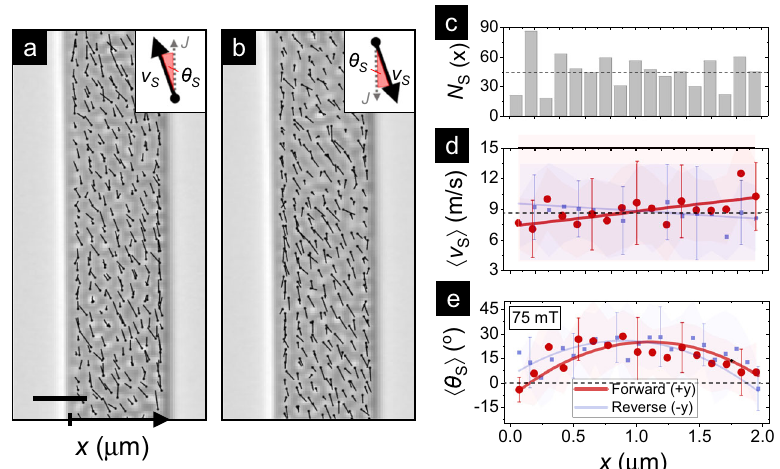
Fig. 3 Con fi nement effects on skyrmion fl ow dynamics. a , b Representative MFM images (scale bar: 1 μ m) at μ 0 H ≃ 75 mT showing the forward ( J k þ ^ y ) ( a ) and reverse ( J k (cid:4) ^ y ) ( b ) plastic fl ow of skyrmions with varying distance x from the left edge. Overlaid dots correspond to initial skyrmion positions and lines show the extent of motion due to the current pulse. Insets de fi ne v S and θ S with respect to J for both cases. c Binned histogram distribution of (cid:1) (cid:3) (cid:1) (cid:3) skyrmions based on their x -positions before motion. d , e Average velocity v S ð x Þ ( d ) and angular de fl ection θ S ð x Þ ( e ) for skyrmions in each x -bin for forward ( J ∥ + ^ y , red) and reverse ( J ∥ - ^ y , blue) motion (details in SM7). Solid lines serve as guides-to-the-eye to indicate trends, while shaded regions represent the standard deviation, also emphasized by error bars for selected